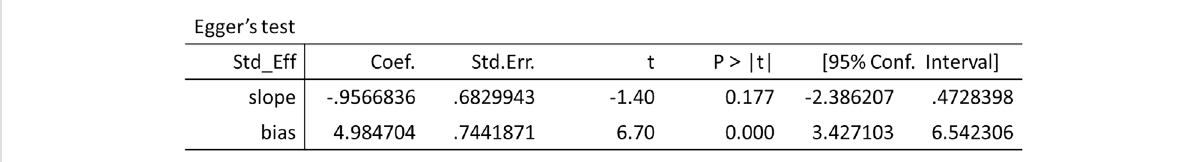
FIGURE 8 Publication bias